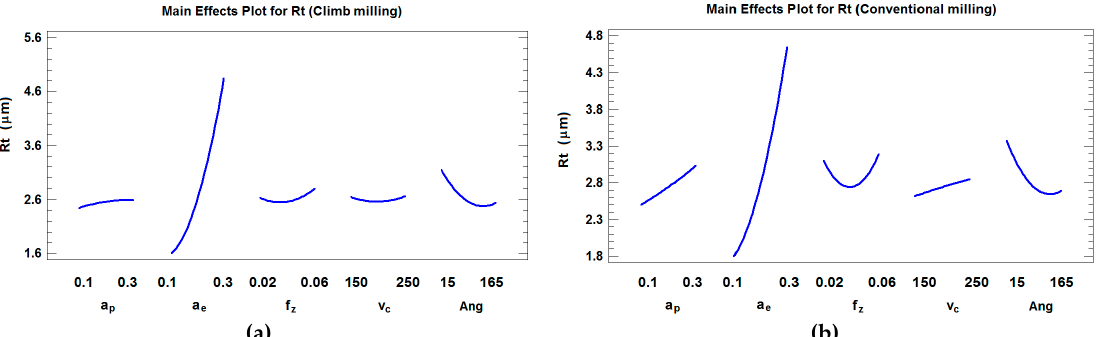
Figure 7. Main effects plot for Rt (considering the position angle) in ( a ) climb milling and ( b ) conventional milling.